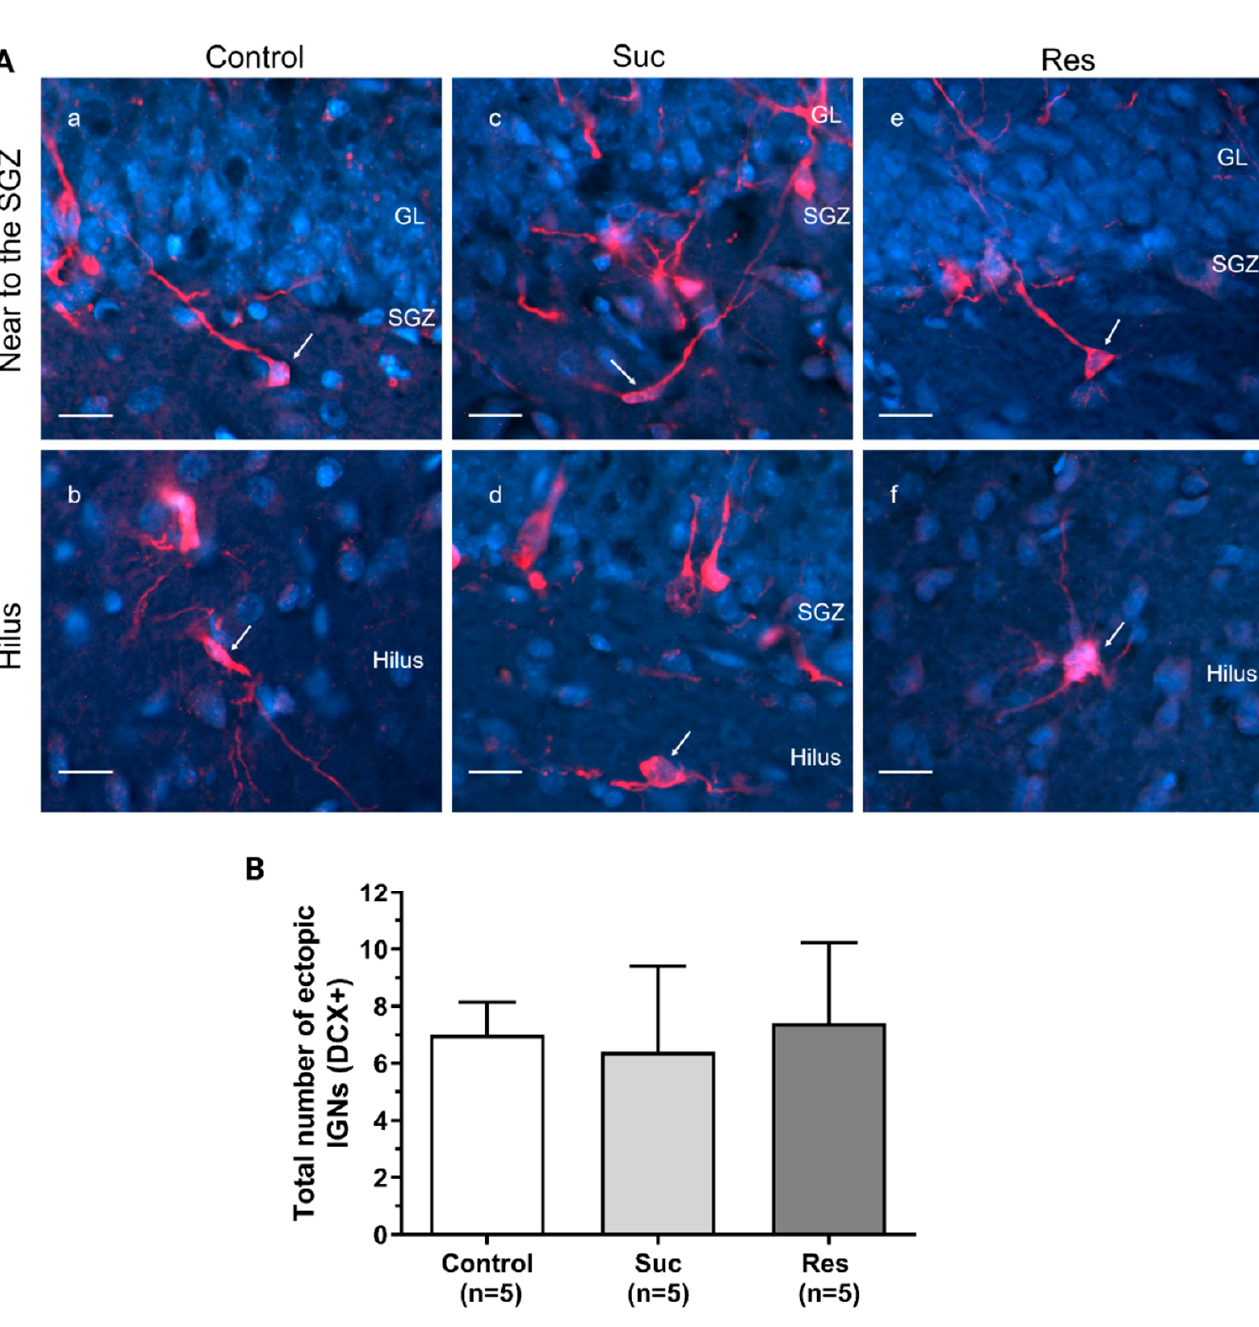
Figure 10. Sucrose consumption during late adolescence does not affect the number of ectopic immature granular neurons (IGNs) in the ventral dentate gyrus. ( A ) Representative photomicrographs of ectopic IGNs (DCX+, red) merged with DAPI (blue) and located near to the subgranular zone (SGZ) or in the hilus in the control (a,b), Suc (c,d) and Res (e,f) groups. The arrows indicate ectopic IGNs. Note that IGNs with ectopic distribution are present not only in sucrose-treated groups but also in the control group. GL: granule cell layer. Scale bar: 20 µ m. ( B ) A cell counting of ectopic IGNs in the ventral dentate gyrus of the control, Suc and Res groups. No significant difference was found among the experimental groups. One-Way ANOVA.